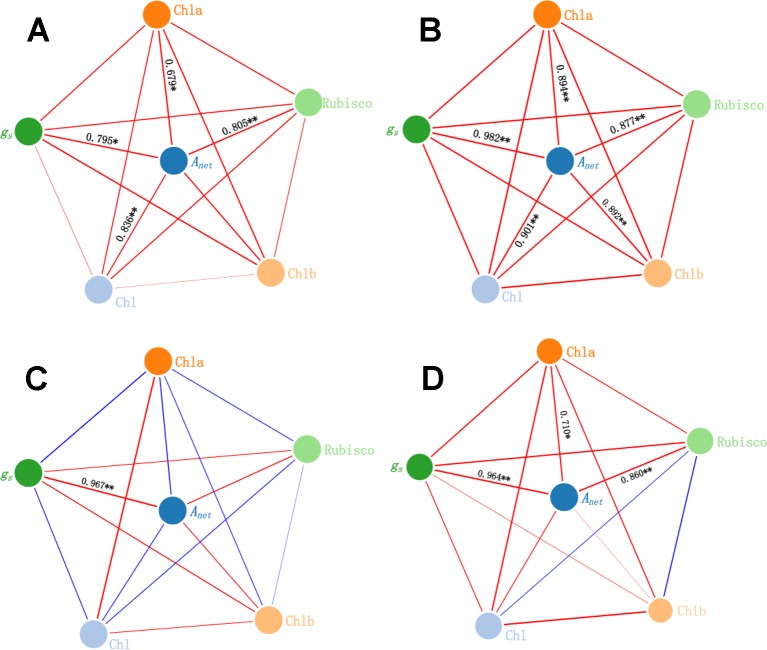
Relationship among gs, Chl, and Rubisco activity and Anet under warming and N deposition. Red lines represent positive relations, while blue lines represent negative relations. The boldness of the lines indicates the strength of the relations. Asterisk (*P < 0.05, **P < 0.01) represents significant difference. Four treatments: (A) CK, (B) N, (C) W, (D) NW.